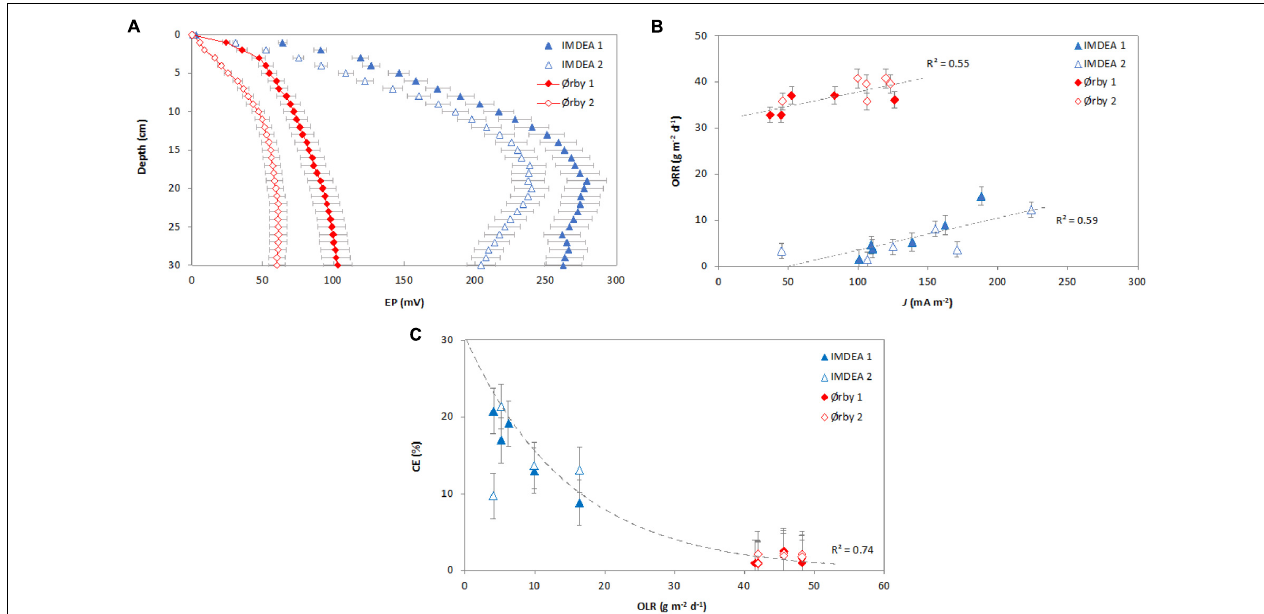
FIGURE 5 | Bioelectrical response of tested METland systems. (A) Electric potential (EP) profiles along water depth; (B) the relation between electron flow density ( J ) and removed organic load rate (ORR) in terms of COD (%); (C) the relation between OLR at the inlet in terms of COD and coulombic efficiency—CE (%). In panel (A) , the EP profiles represent the average of different sampling values (for IMDEA systems: n = 18; for Ørby systems: n = 6). In panels (B,C) , each marker represents average values (for IMDEA systems: n = 3; for Ørby systems: n = 2). In all figures, error bars indicate the standard error of the